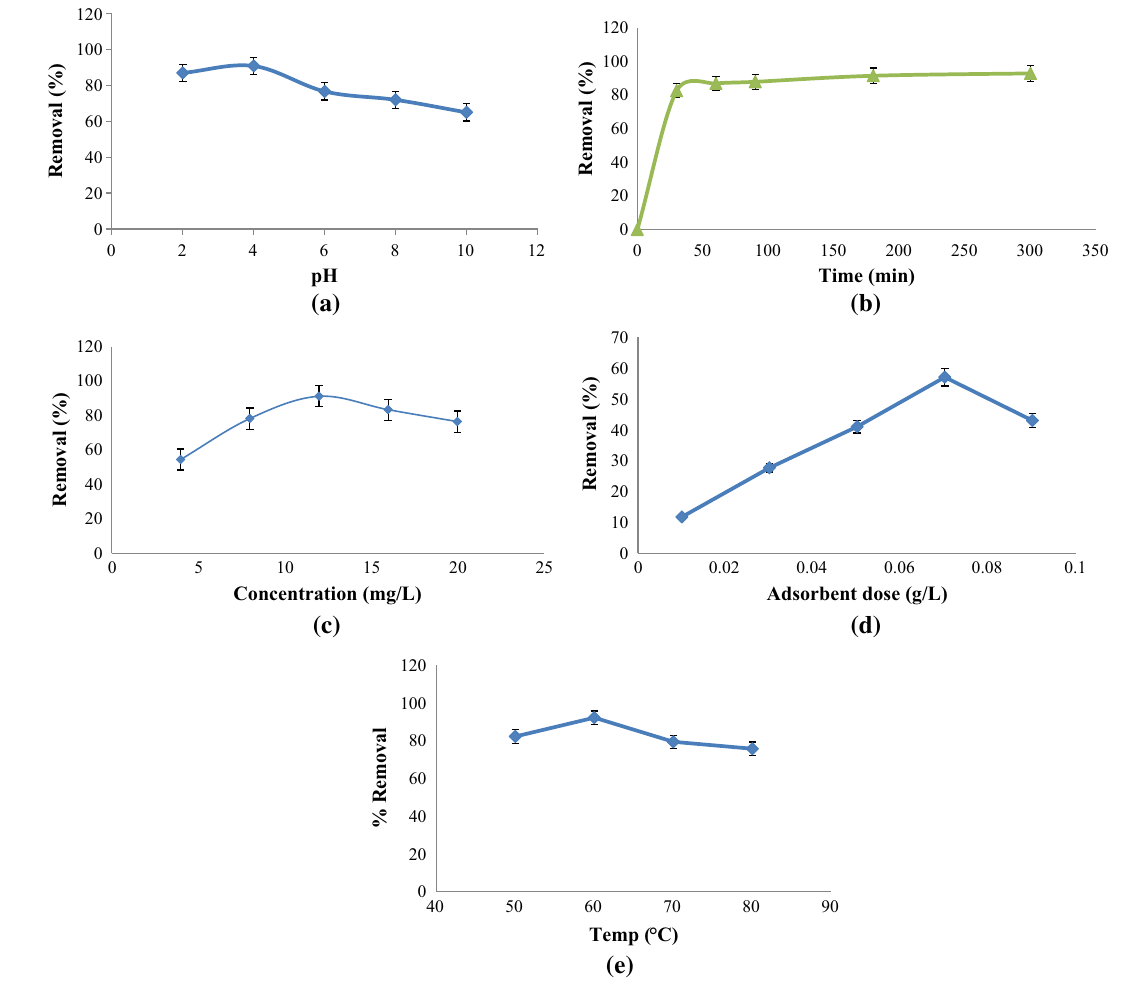
Fig. 3 a – e Effect of individual